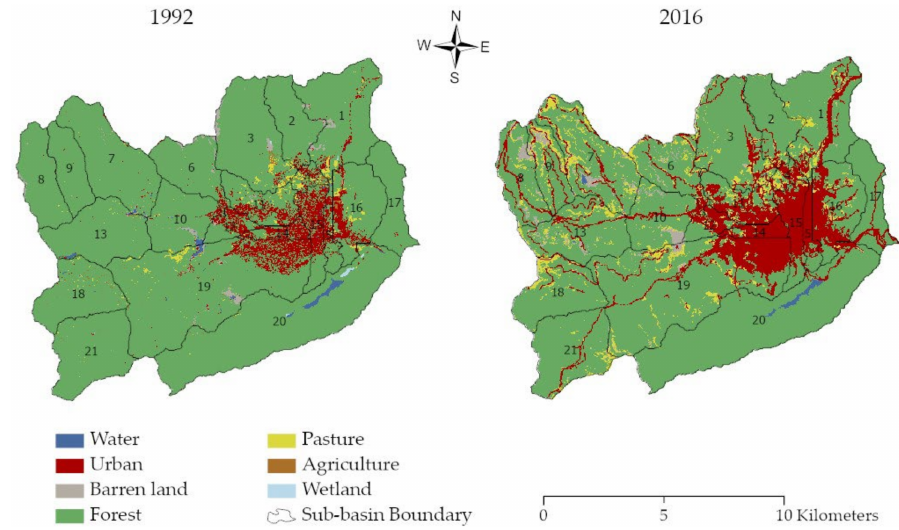
Figure 9. LULC map (1992 & 2016) of the Yellow Creek